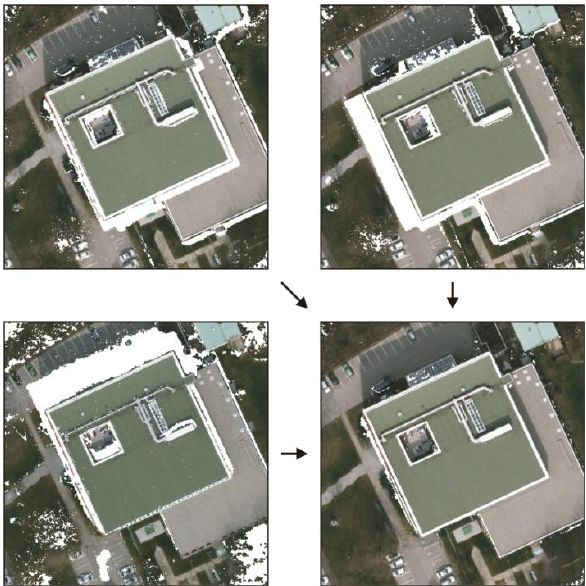
Figure 4: Merge of info clouds from individual frame stereo pairs, based on DMC-II data. Top: section from a single strip, flown West to East. Bottom left: corresponding info cloud from the adjacent strip. Bottom right: Final result, combining data from all three info